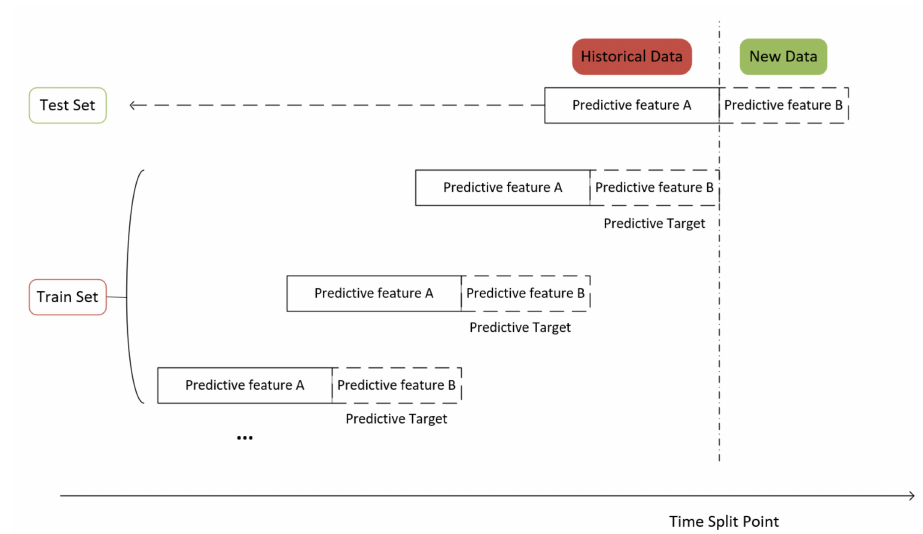
Figure 5. Schematic diagram of sliding data